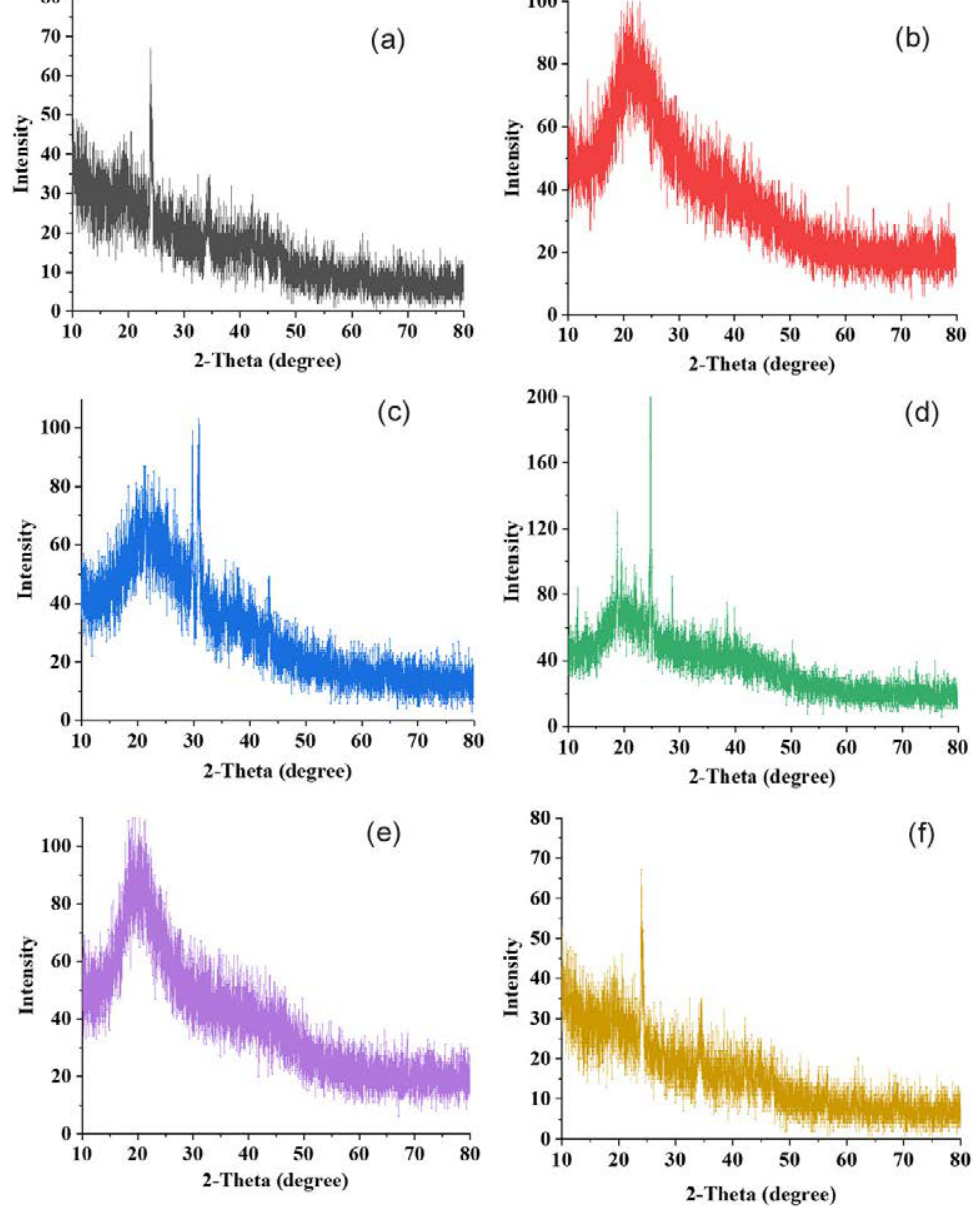
Fig. 6. X-ray diffraction (XRD) patterns of A. modesta crude (a) purified (b) acidic hydrolysis (c) basic hydrolysis (d) polyacrylamide grafting (e) carboxymethylation